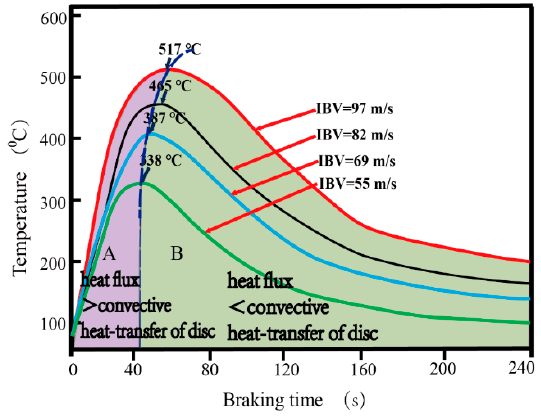
Figure 13. Relationship between transient temperature and IBV of 55~97 m/s under 22 kN.